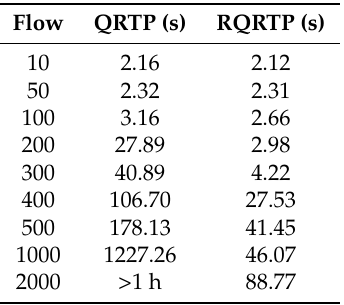
Table 4. Computational